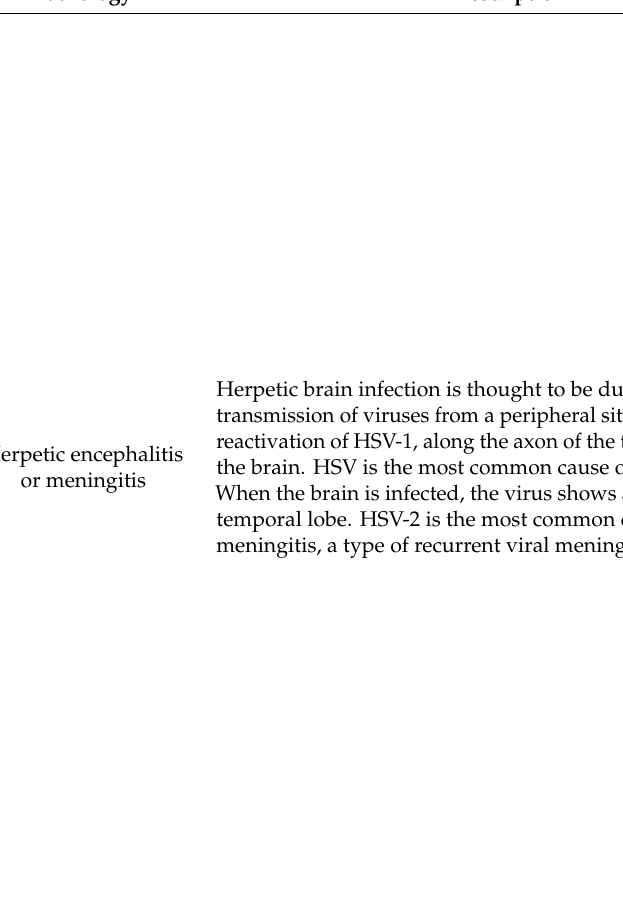
Figure 5. Herpes simplex encephalitis, licence CC BY 3.0, adapted with concession of Dr Laughlin Dawes